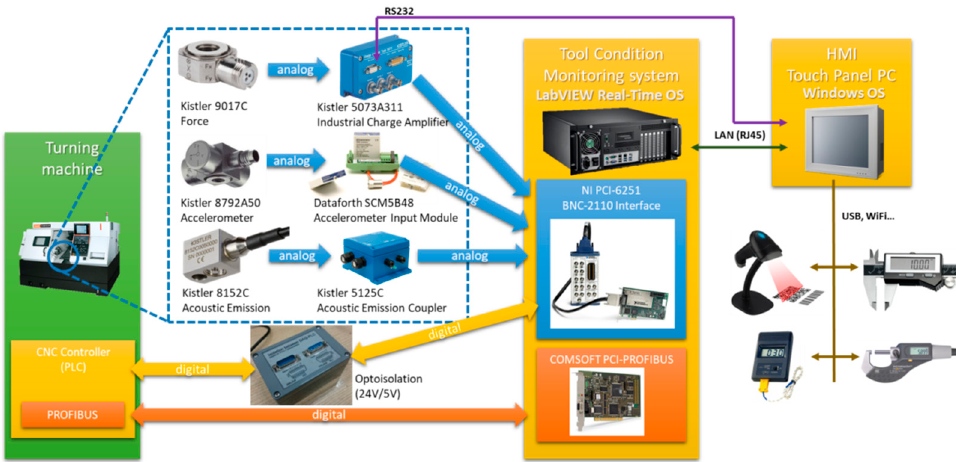
Figure 3. TCM system created by Warsaw University of Technology [46].